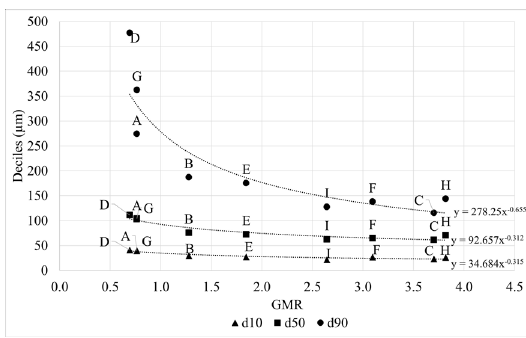
Figure 7. Deciles (d90, d50 and d10) as a function of GMR.